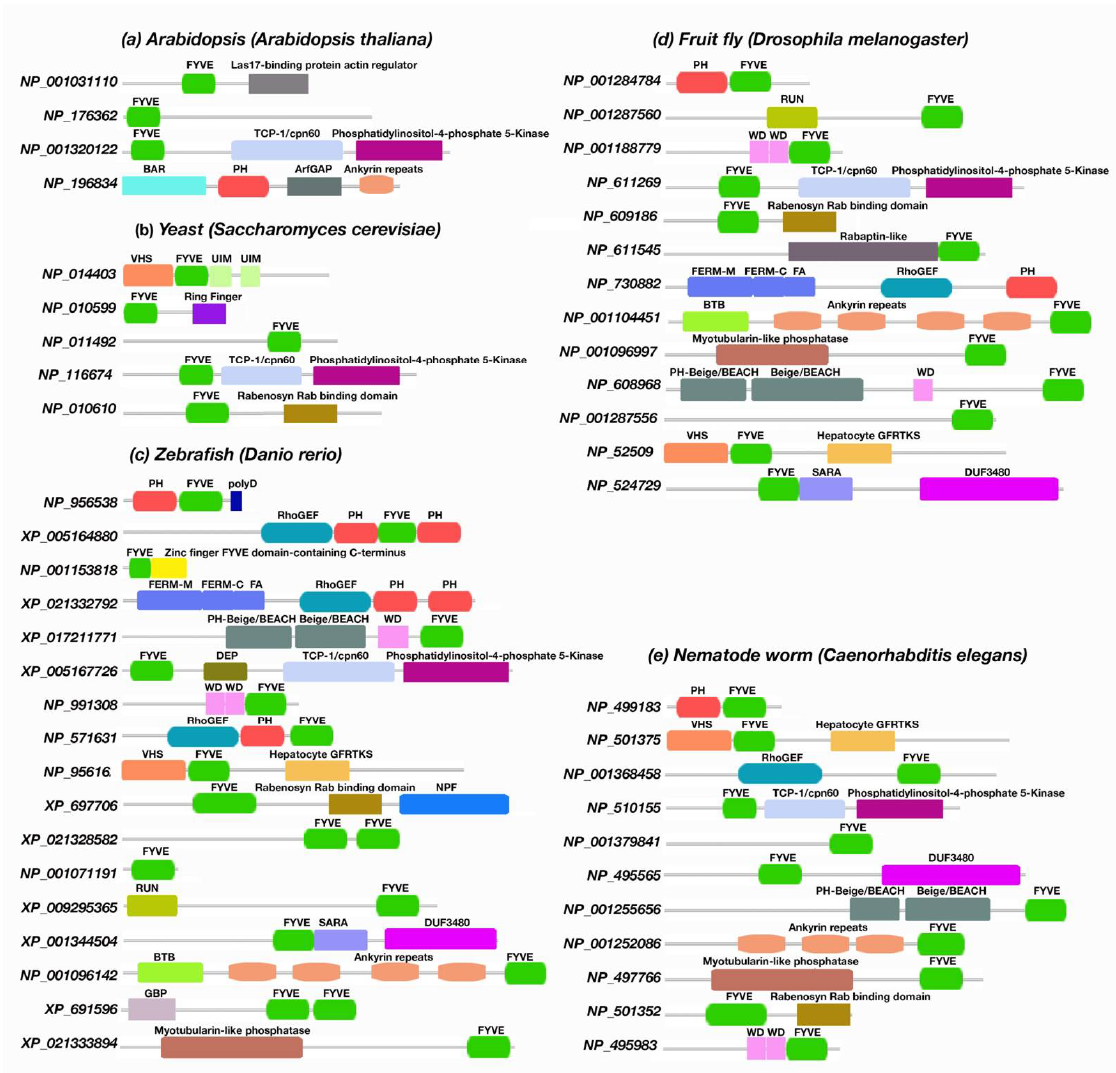
Figure 6. Availability of PH-, FYVE-, and polyD-containing modules in model organisms. ( a ) Ara- bidopsis thaliana , ( b ) Saccharomyces cerevisiae , ( c ) Danio rerio , ( d ) Drosophila melanogaster , and ( e ) Cae- norhabditis elegans .